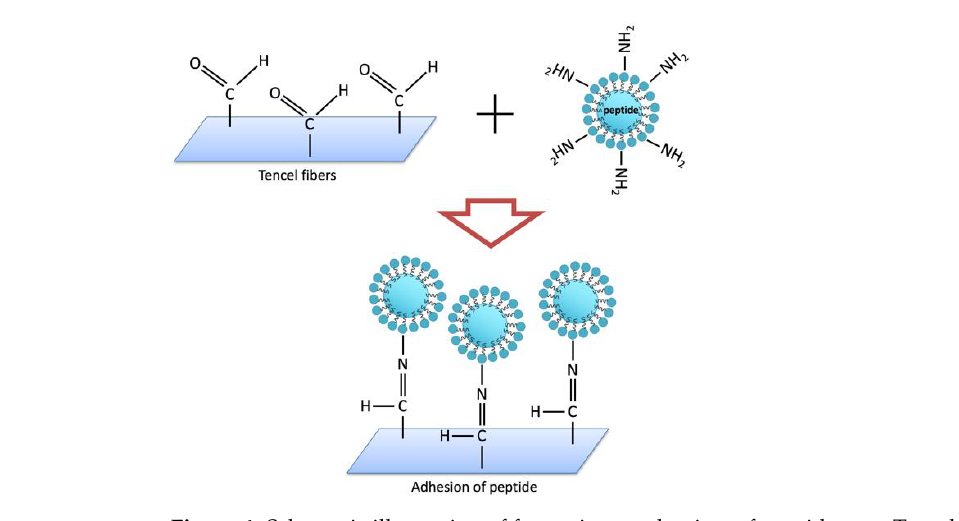
Figure 4. Schematic illustration of formation mechanism of peptide onto Tencel membranes.